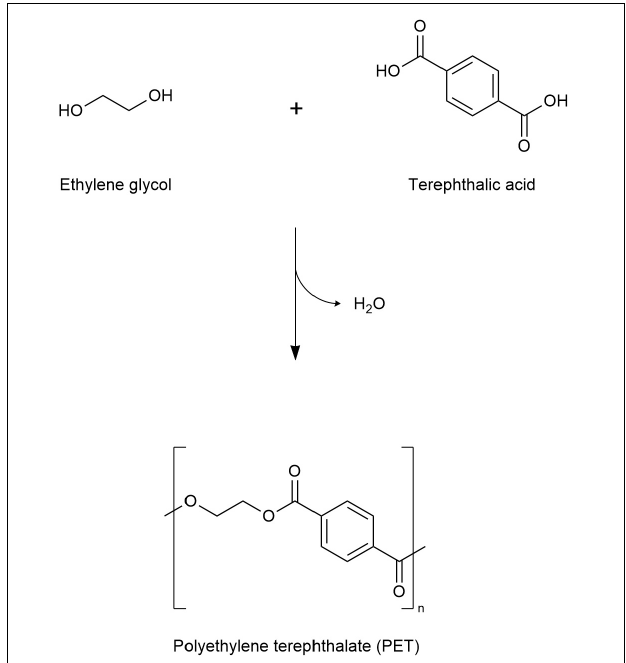
FIGURE 1 | Structure of PET polymer. Polycondensation reaction of ethylene glycol (EG) and terephthalic acid (TPA) monomers gives polymeric polyethylene terephthalate (PET), with water as a